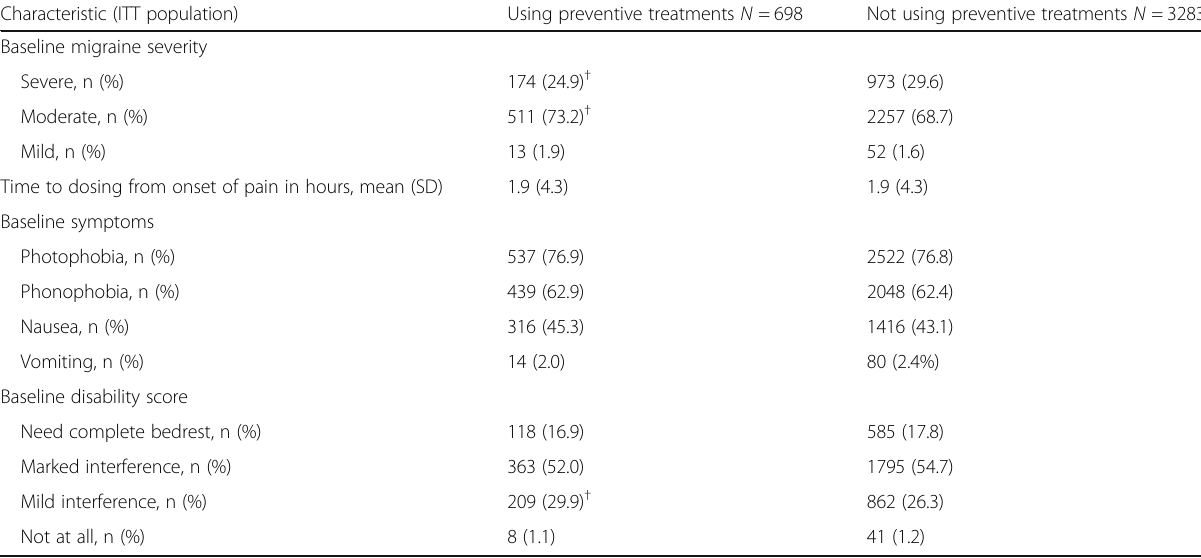
Table 2 Baseline characteristics of treated migraine attacks for patients using and not using migraine preventive medications Characteristic (ITT population) Using preventive treatments N = 698 Not using preventive treatments N =